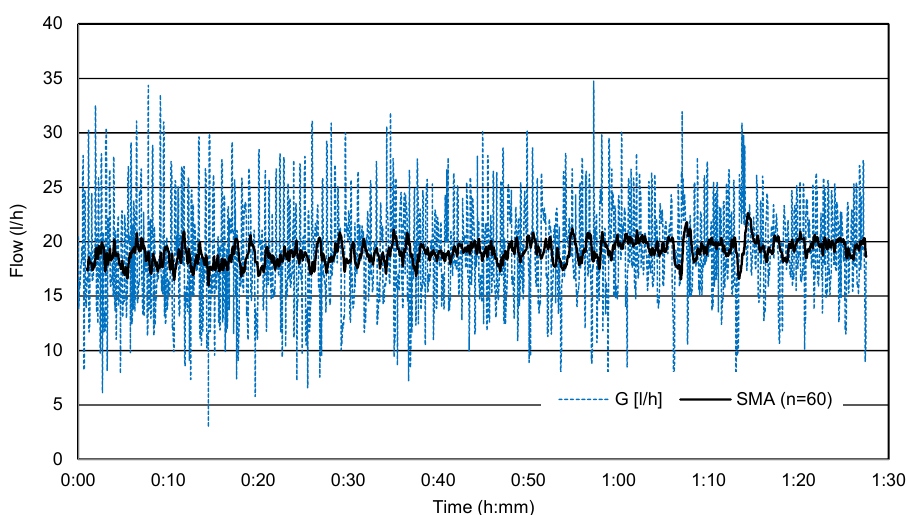
Figure 11. Instantaneous flow rate of the liquid heat transfer medium in the laboratory model at 600 W.